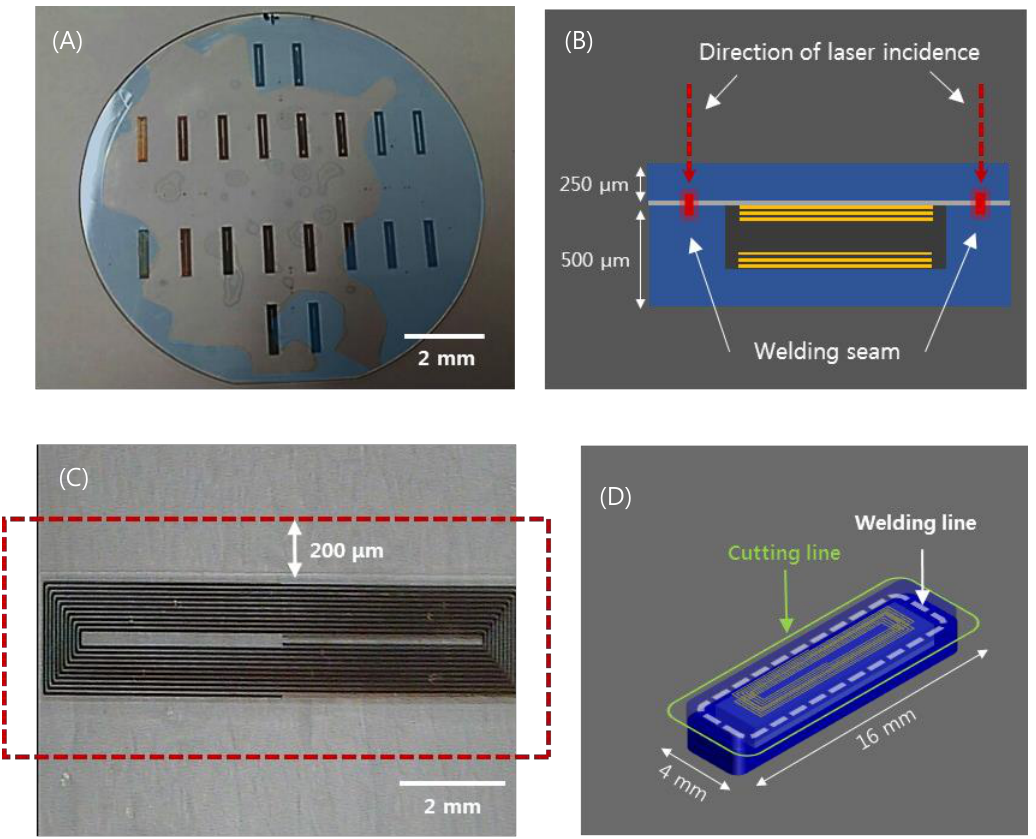
Figure 2. ( A ) Wafer-state of sensors fabricated by MEMS process. ( B ) depiction of the laser welding (sensor thickness 750 µ m). ( C ) visualization of the welded area near the inductor of a sensor. ( D ) visualization of the laser cut path for individualization and miniaturization of sensors (sensor cutting size: width 4mm, length 16 mm).